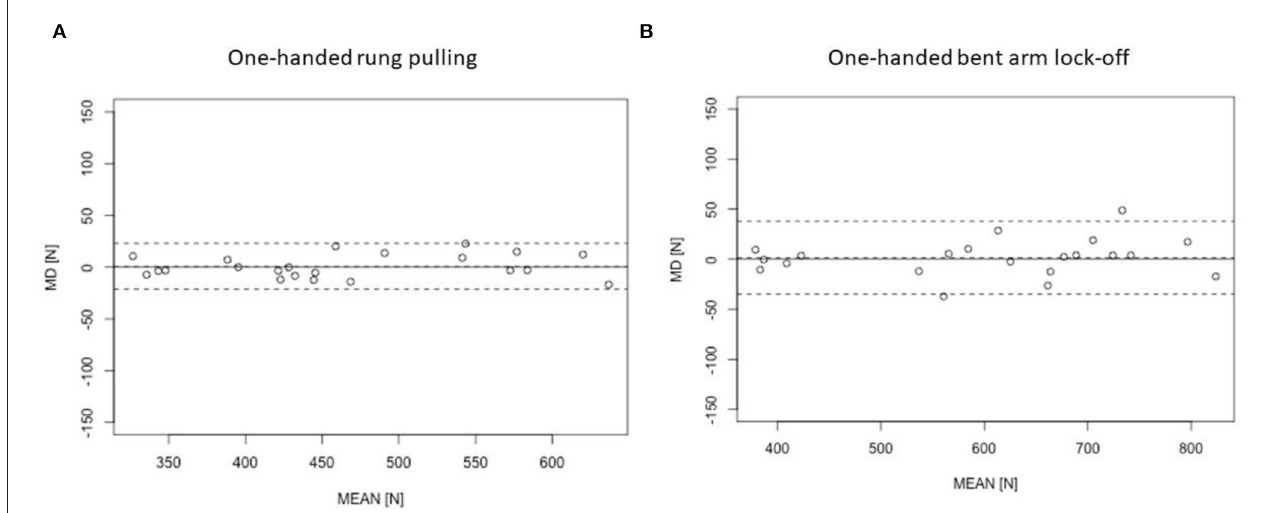
FIGURE 1 | Bland–Altman plots (MD, mean difference between both devices; MEAN, average of both devices) for the validity of the Tindeq vs . Kistler for (A) one-handed rung pulling and; (B) one-handed bent arm lock-off. The dashed line indicates 95% limit of agreement. The first test session is displayed.